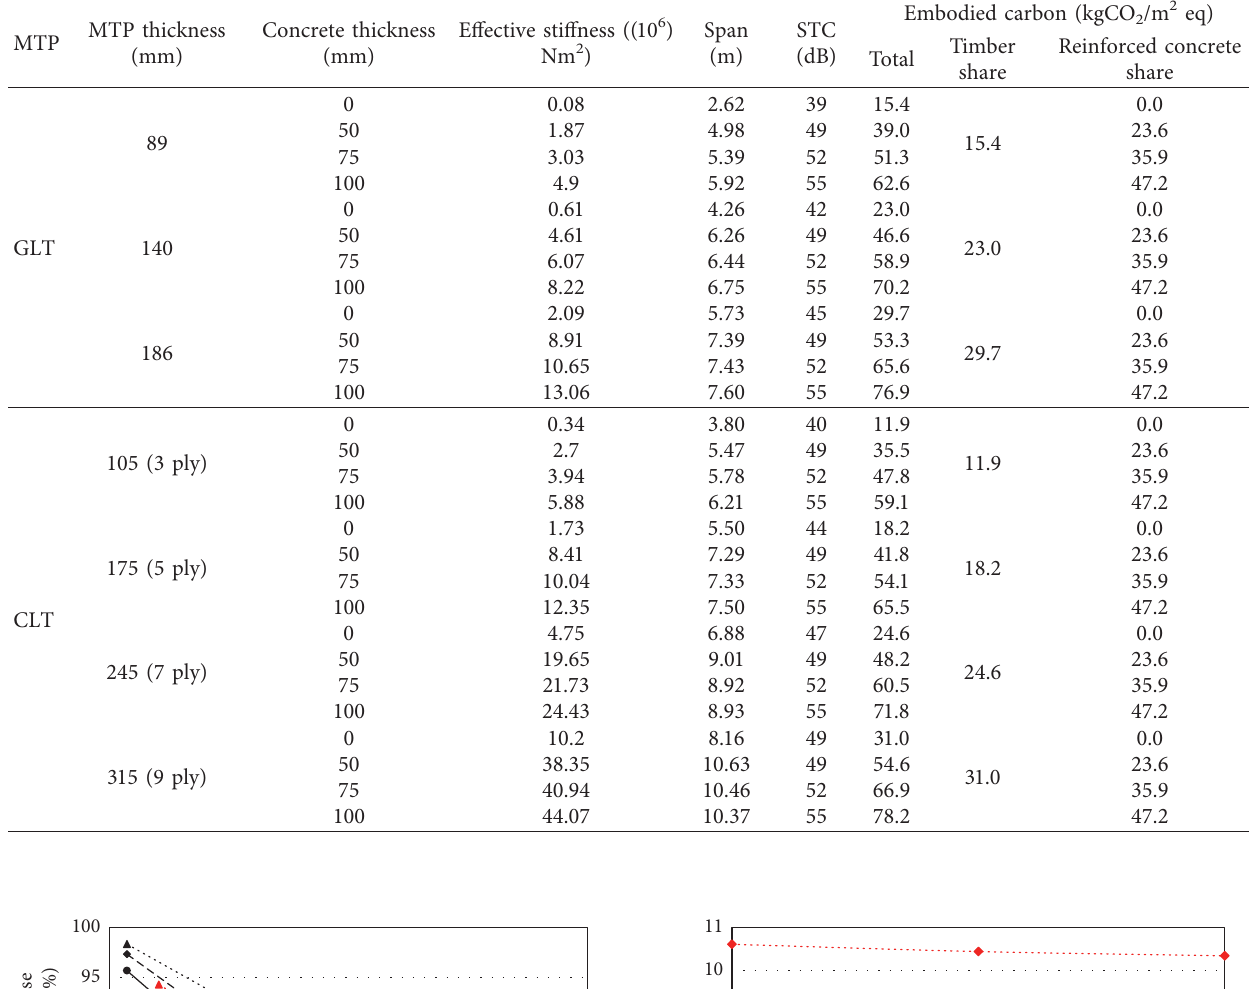
Table 3: TCC allowable floor spans with associated embodied carbon for 250 mm spaced connectors.